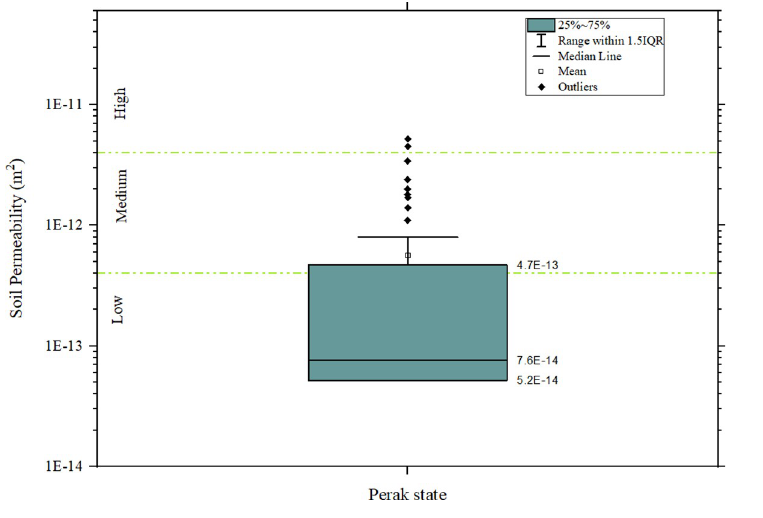
Fig 5. Box plot of soil gas permeability of Perak